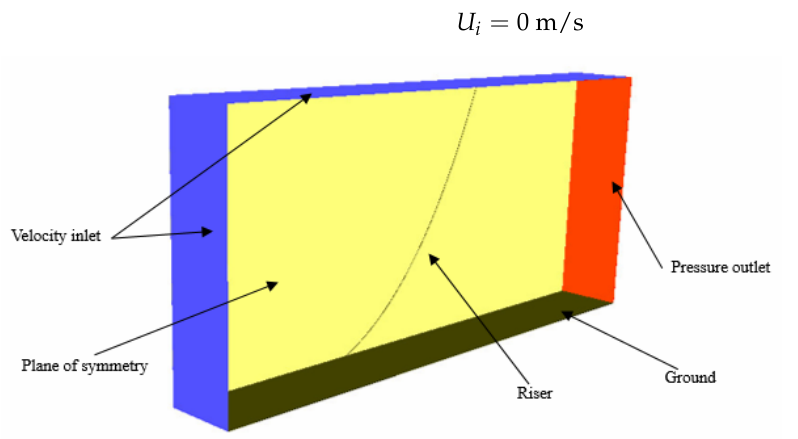
Figure 4. Schematic diagram of boundary condition types.